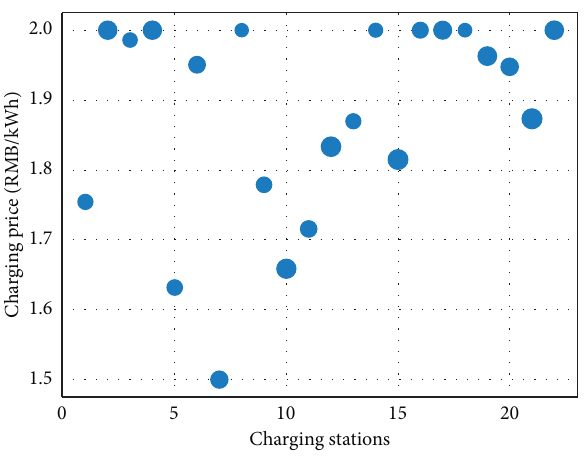
Figure 18: Charging price with optimization.